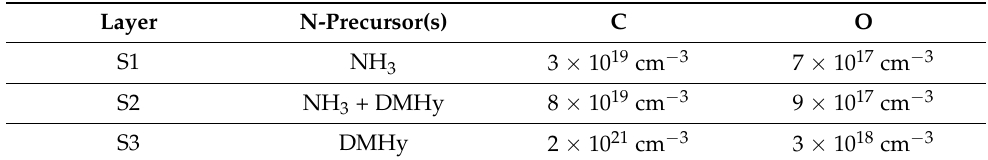
Table 2. Impurity concentrations (C, O) in LT GaN layers with varying N-precursors, determined from SIMS